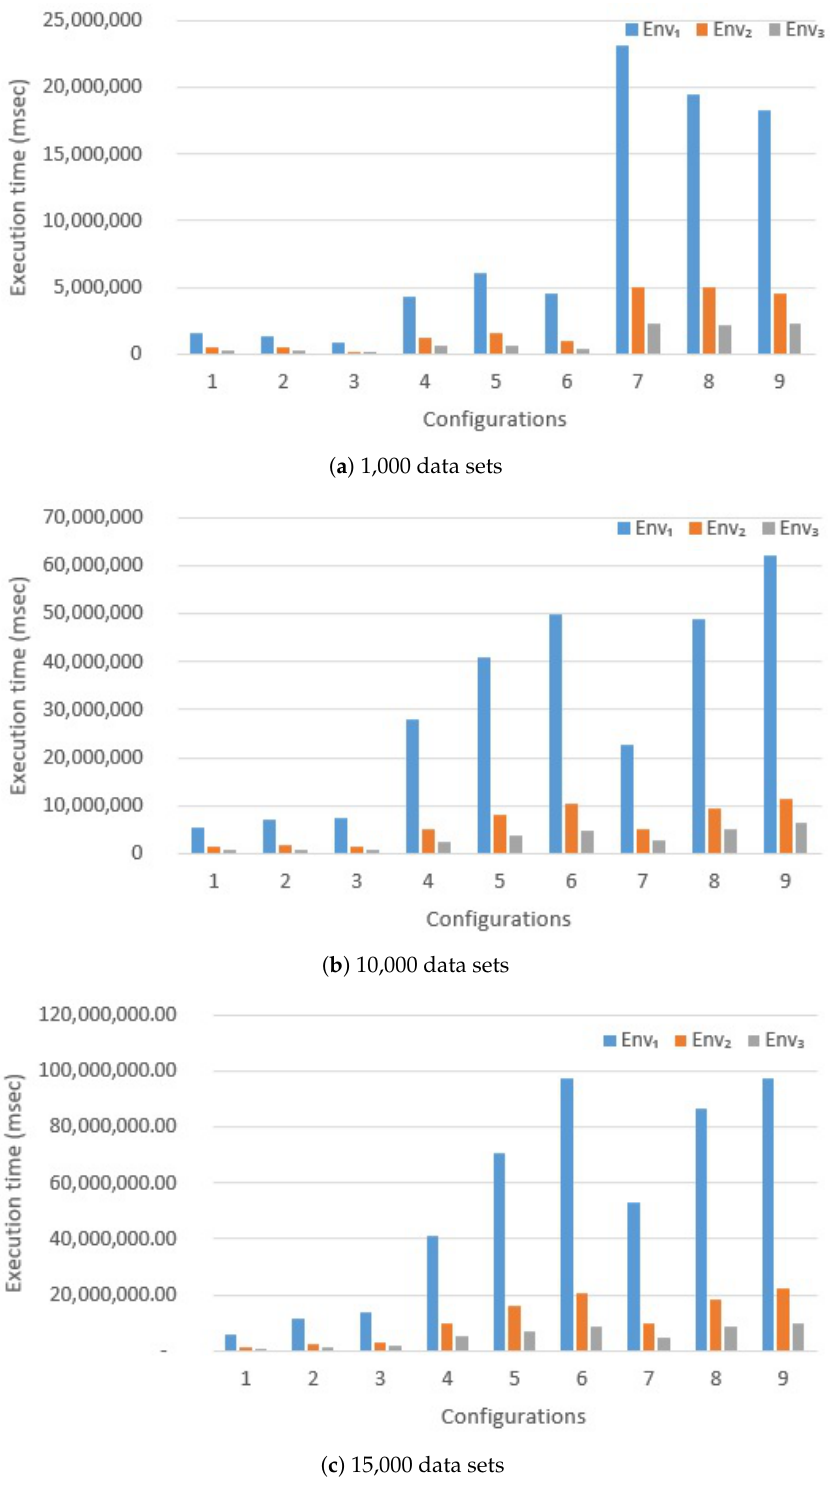
Figure 6. Comparing execution times of Step 4 for each configuration, among the three different execution environments for the basic Map-Reduce